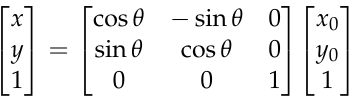
Figure 4. Preprocessing of sugarcane images: ( a ) inverse binary image, ( b ) corroded image, ( c ) di- lated image, ( d ) circumscribed rectangle, and ( e ) image after correction. angle of sugarcane’s circumscribed rectangle with respect to the horizontal axis. The coordinates of the four vertexes of the circumscribed rectangle of the sugarcane can be obtained simultaneously. Affine transformation was used to rotate the input image by angle − θ . Figure 4e is the output image after correction.